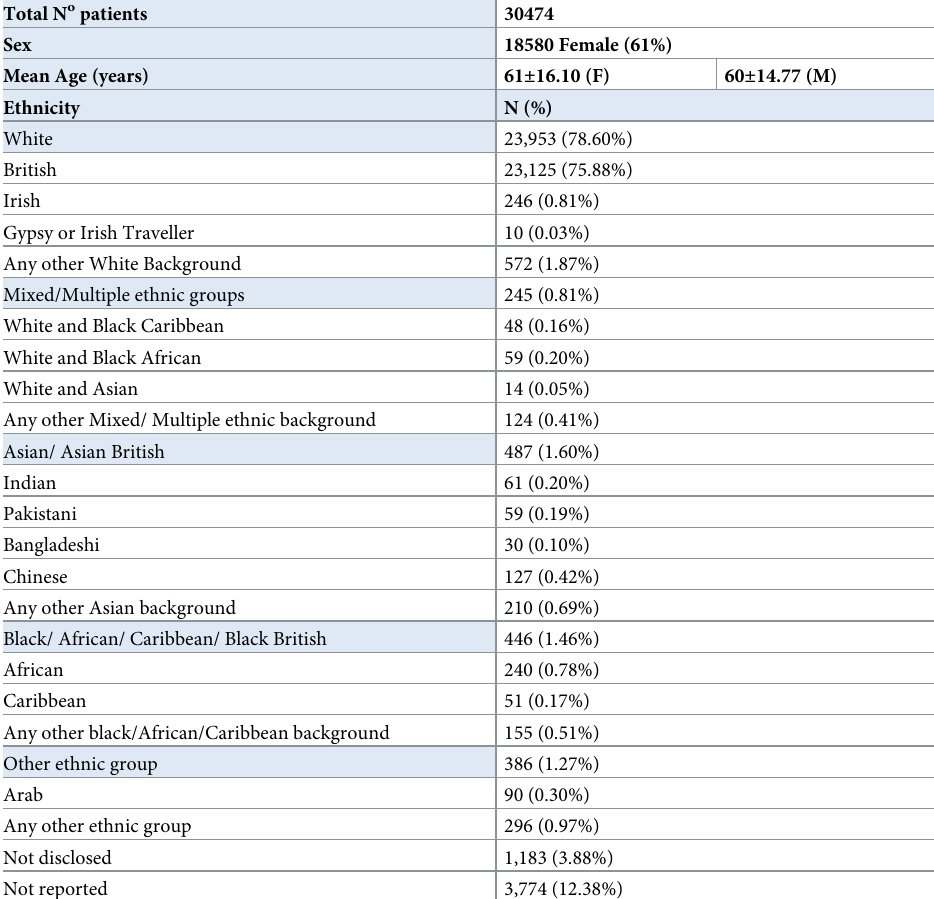
Table 2. Patient demographics.